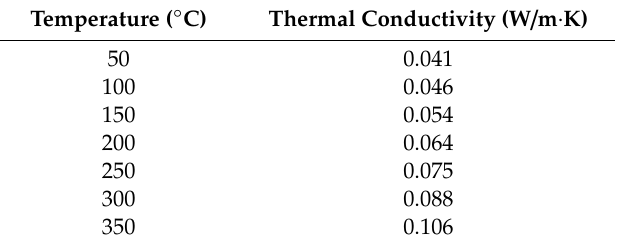
Table A2. Thermal conductivity of the thermal insulation studied (Rockwool ProRox PSM 971, 50 mm) [29].